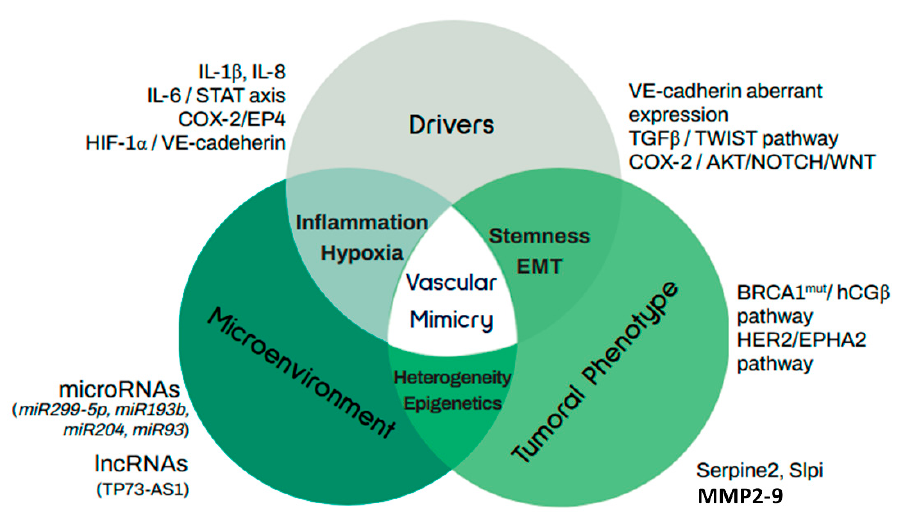
Figure 3. Molecular regulators of vascular mimicry. Vascular mimicry in cancer is activated by several drivers associated with phenotypic features of tumors and microenvironmental factors and signals. Tumor phenotype relates to stemness and EMT capacity of cancer cells. Molecular drivers include TGFB/TWIST regulation of the stem cellular subpopulation and the aberrant expression of VE-cadherin, while the COX-2 axis regulates stemness and VM capacity by PI3K/AKT activation and induction of NOTCH/WNT expression. In the context of breast cancer, the main mechanisms associated with stemness are mediated by hCG β in BRCA1 mutated patients and by EPHA2 in HER2+ tumors. Heterogeneity in breast cancer tumors is associated with the activation of VM and metastasis through the expression of anti-coagulant factors Serpine2 and Slpi. Along with this, highly invasive breast tumors overexpress metalloproteinases as MMP2 and MMP9, which participate in VM by remodeling the extracellular matrix. Regarding epigenetic regulation of VM, ncRNAs, including several microRNAs as well as lncRNA participate in this process. Well-known microenvironment factors and drivers inducing VM include IL-1 β , IL-8, and IL-6. Finally, HIF1A activation in response to hypoxic conditions is highly involved with VE-cadherin expression through TWIST1. Author Contributions: Conceptualization, writing—original draft preparation and visualization, G.M.-G., E.A.M.-P. and L.D.; writing—review and editing, R.G.-B., J.G.-Q., and E.A. All authors have read and agreed to the published version of the manuscript. Funding: This research was funded by Consejo Nacional de Ciencia y Tecnología (CONACyT), México, grant number A1-S-10749 to L.D. Institutional Review Board Statement: Not applicable. Informed Consent Statement: Not applicable. Data Availability Statement: Not applicable. Acknowledgments: This review is part of the Ph.D. work of G.M.-G. who is a student from El Programa de Doctorado en Ciencias Biomédicas, Universidad Nacional Autónoma de México (UNAM). G. M.-G. is receiving a fellowship from Consejo Nacional de Ciencia y Tecnología de México (CONACyT). Conflicts of Interest: The authors declare no conflict of interest. Abbreviations D DAH1